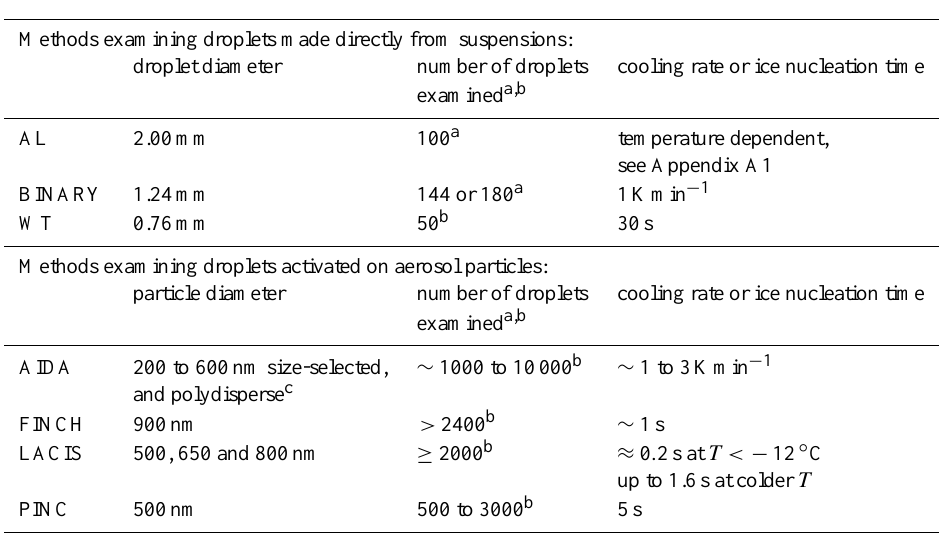
Table 1. Experimental details for the different measurement techniques/instruments. Methods examining droplets made directly from suspensions: droplet diameter number of droplets cooling rate or ice nucleation time examined a,b